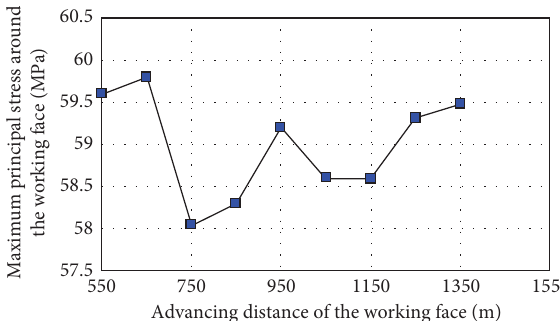
Figure 7: Relationship between the maximum principal stress around the working face and the advancing distance.